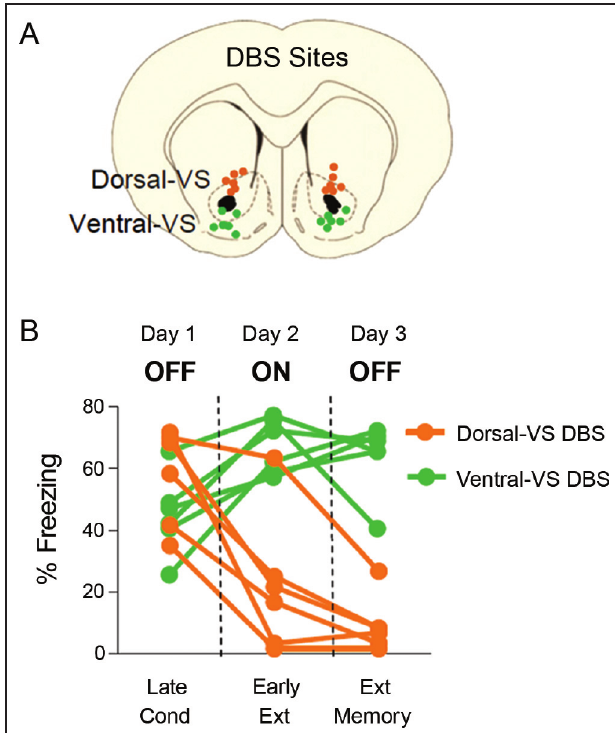
DBS of ventral-VS increased activity in BA. DBS of either VS site increased activity in